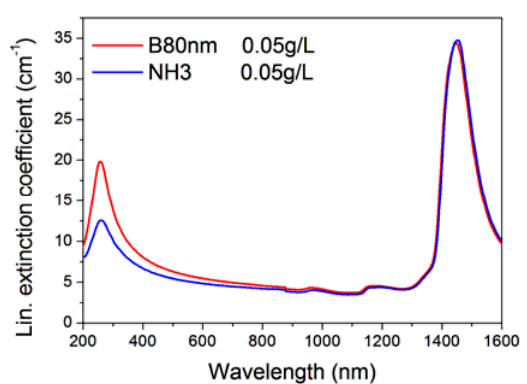
Figure 2. Spectral linear extinction coefficient of samples B80nm and NH3 for the same 0.05 g/L concentration.